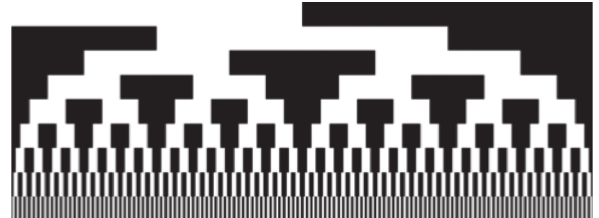
Figure 3: Gray code sequence.